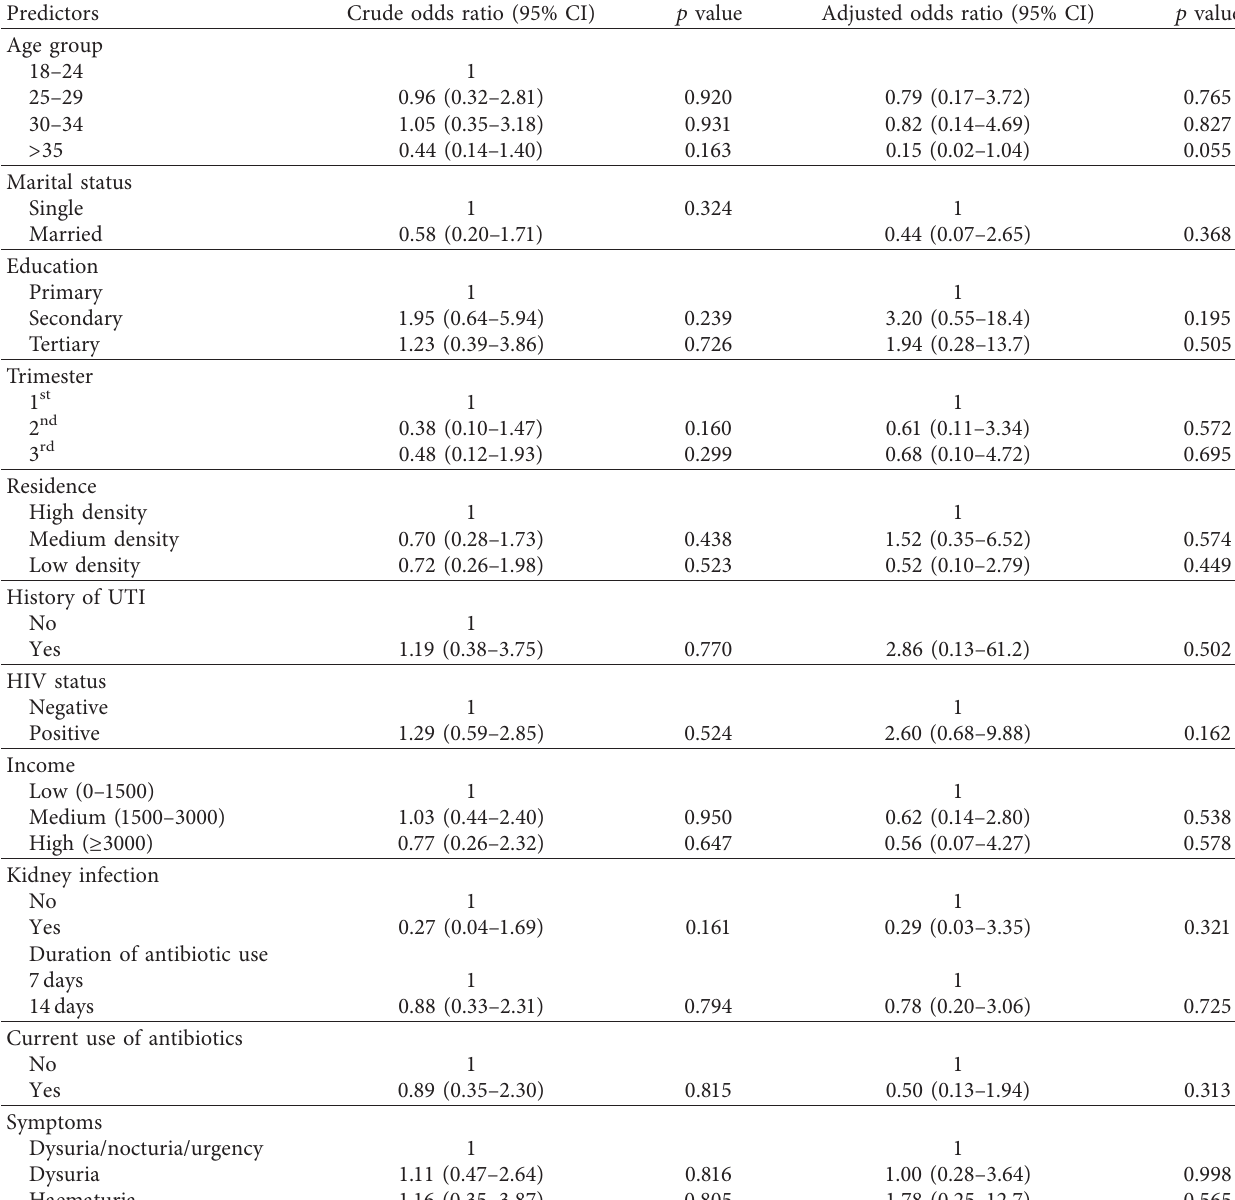
Table 4: Multivariant determinants of antimicrobial